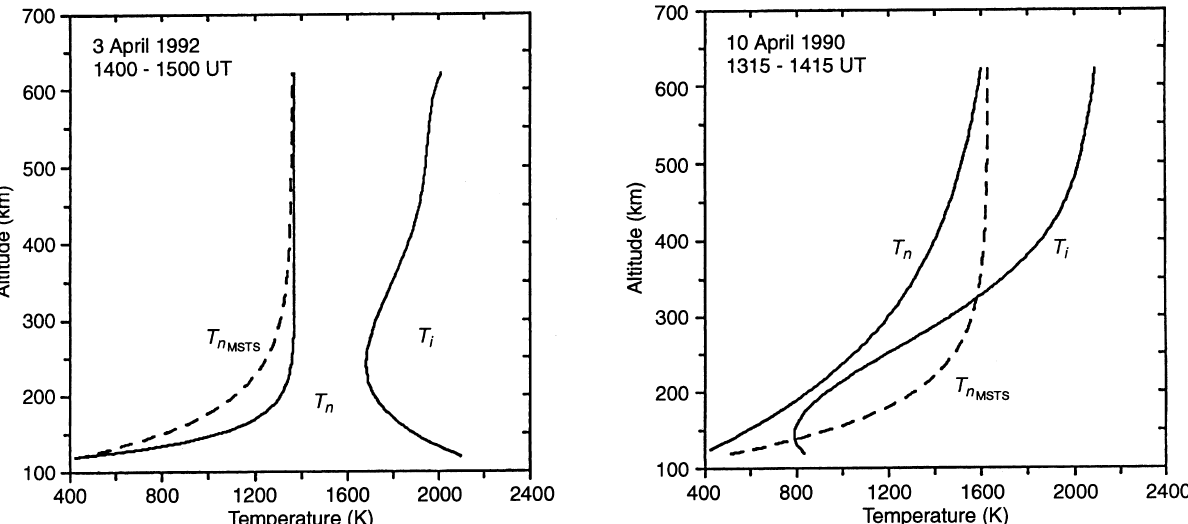
Fig. 6. Calculated and MSIS-83 T ( right )